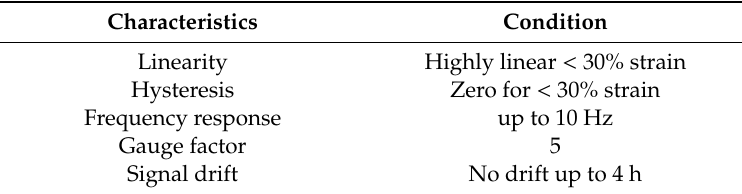
Table 1. Characteristics of the strain